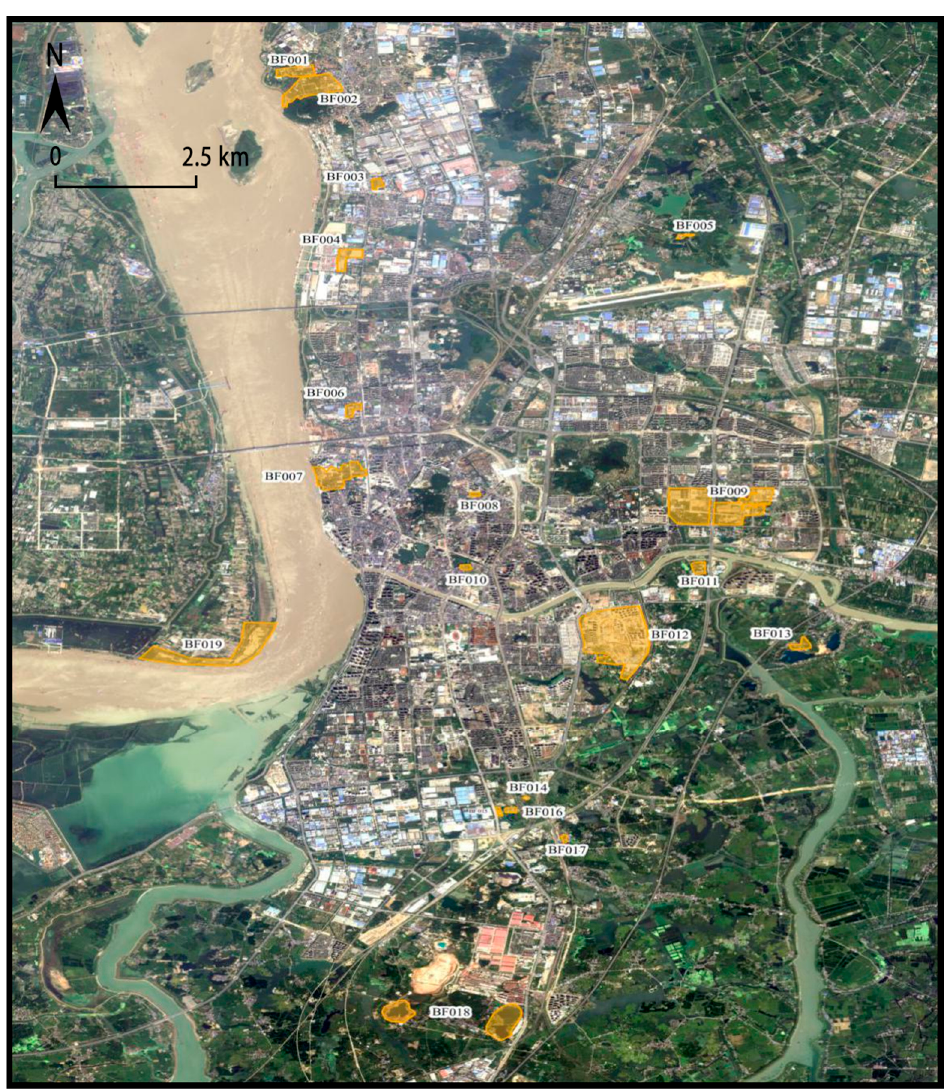
Figure 4. Distribution and spatial extent of brownfields in Wuhu City. Source: own study using data from Table 2.